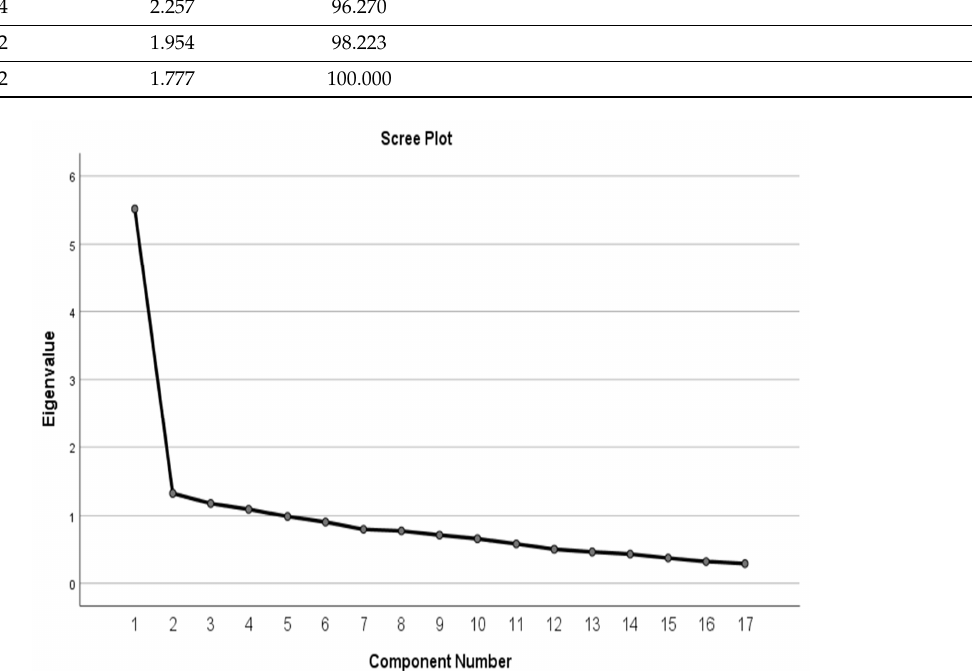
Figure 1. Scree plot chart and extracted factors based on Eigenvalues. Table 4. Rotated Principal Component Matrix of PCQ-P.